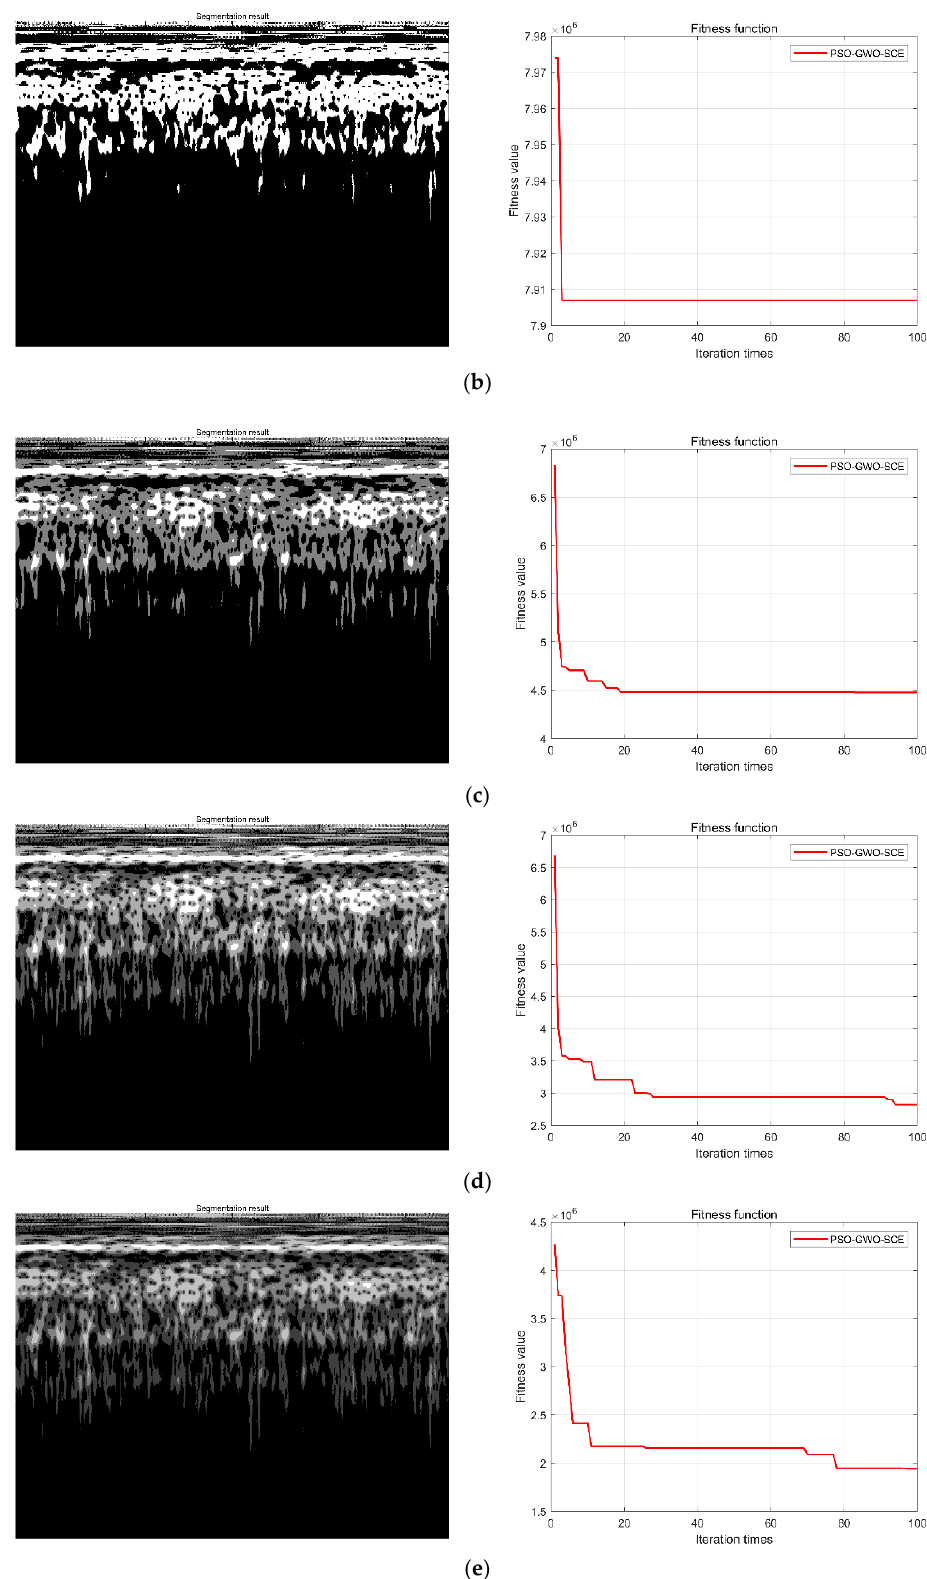
Figure 15. Adaptive multi-threshold segmentation results of the F5 CWT image: ( a ) F5 CWT image; ( b ) single threshold segmentation and GWO iteration results; ( c ) two threshold segmentations and GWO iteration results; ( d ) three threshold segmentations and GWO iteration results; ( e ) four threshold segmentations and GWO iteration results.